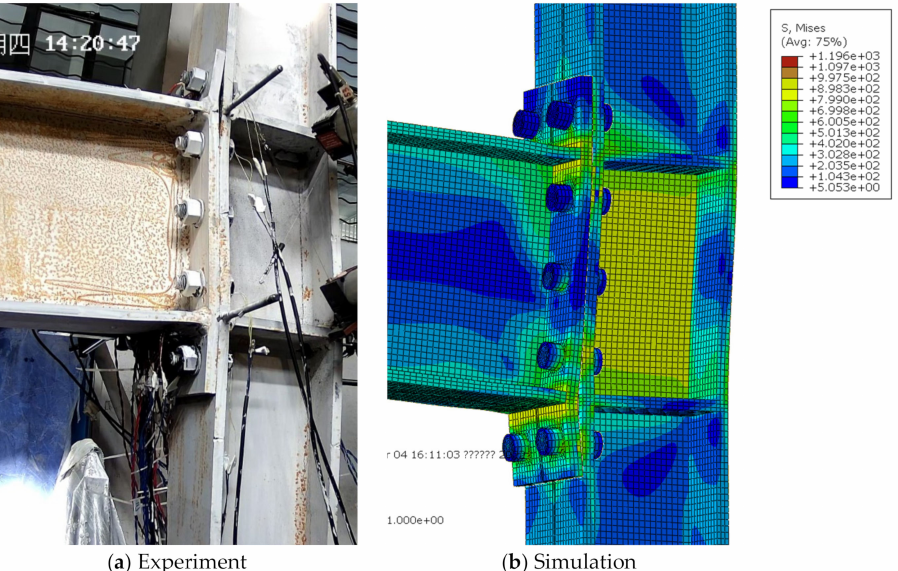
Figure 9. Comparison of experimental and simulated deformation modes in specimen S4 at the first positive peak of 8% loading